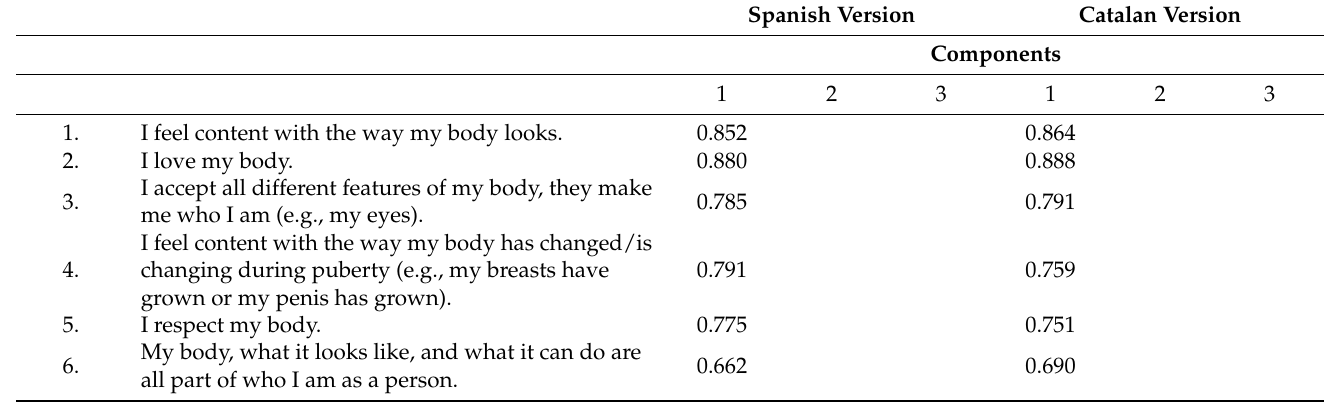
Table 2. Principal Component Analysis of the Spanish and the Catalan